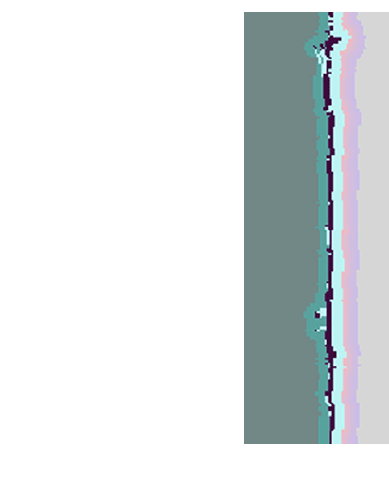
Figure 10. Physics-based methods for human motion prediction: ( a ) trajectory prediction using a CTRA model: sensed positions in blue and predicted positions in red; and ( b ) linearization of